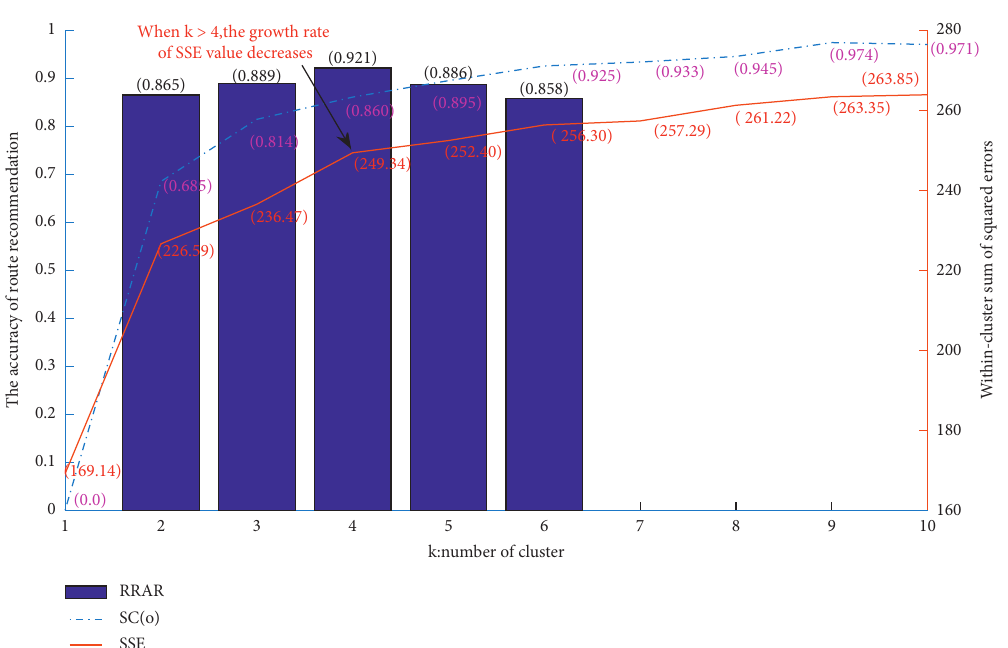
Figure 4: Evaluation index of clustering quality and accuracy with different K